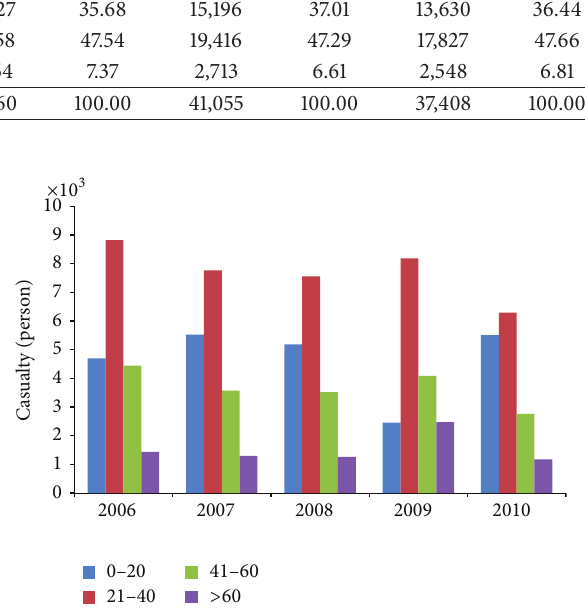
Figure 1: Motorcyclist casualty by age group in